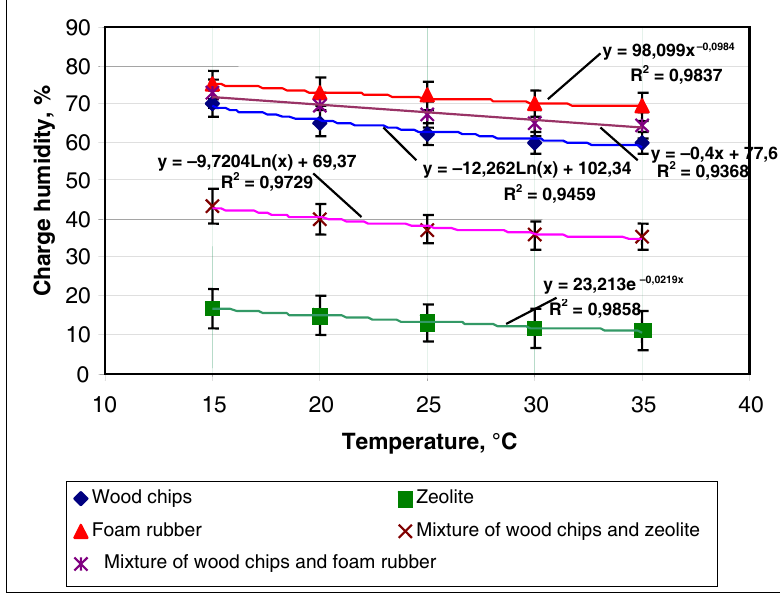
Fig 6. Dependence of the charge humidity on the supplied airflow